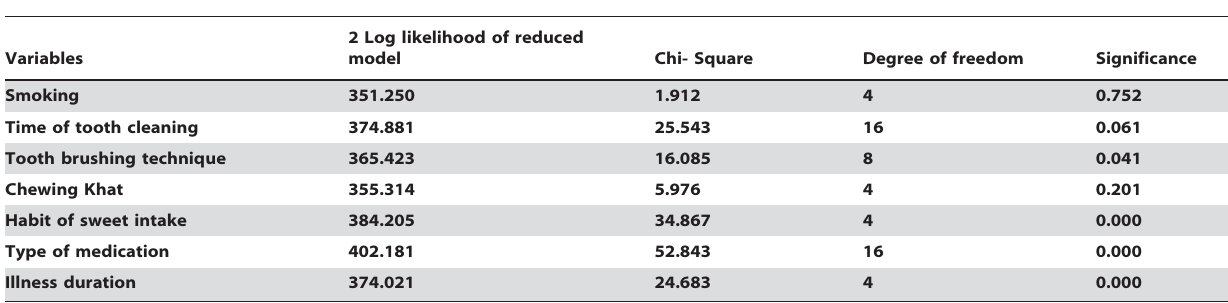
Table 5. Multiple logistic regression analysis model for risk factors against CPI